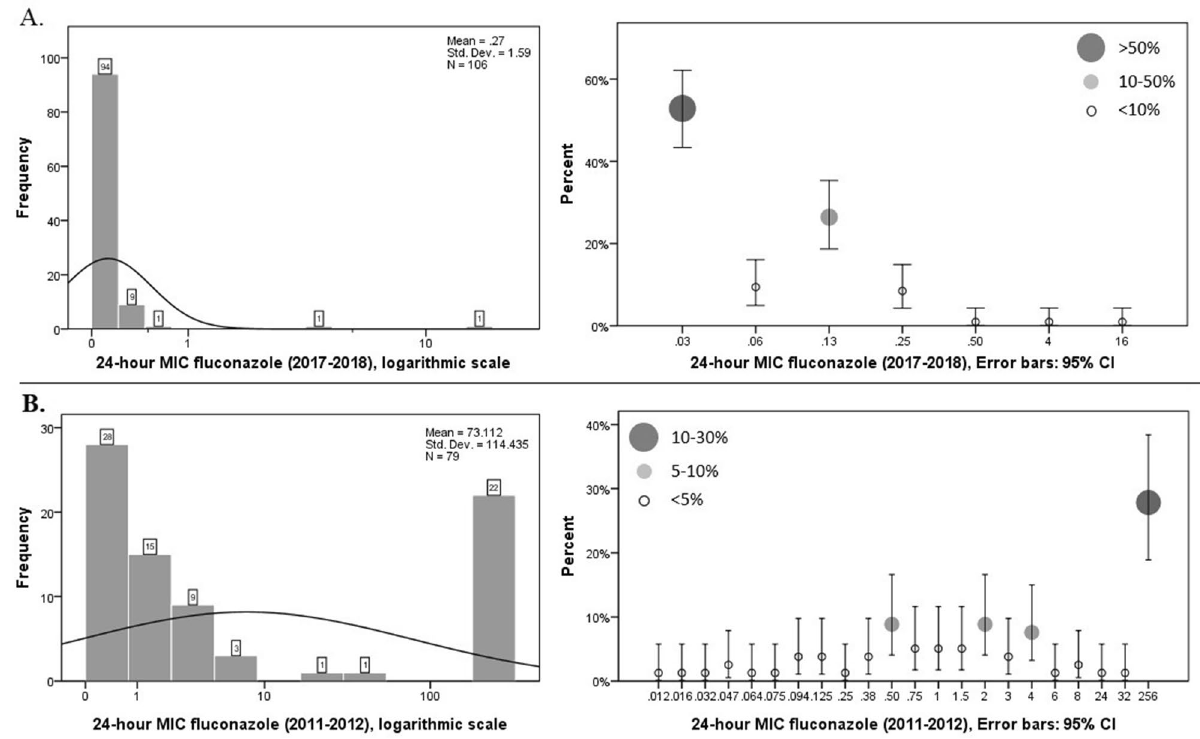
Figure 2. 24-h MIC fluconazole of 117 (2011–2012), and 106 (2017–2018) strains of C. albicans . ( A ) Illustrate chart bar (left) which each bar is labeled with the number of isolates and logarithmic scales (right) of 24-h MIC fluconazole during p2 (2017–2018) which Frequency of MIC results is presented in error bars with 95% CI. Each error bar is labeled by circles that are representative of MIC frequency. ( B ) Illustrate chart bar (left) and logarithmic scales (right) of 24-h MIC fluconazole during p1 (2011–2012). MIC distribution histogram also is provided for better comparison between the two periods.